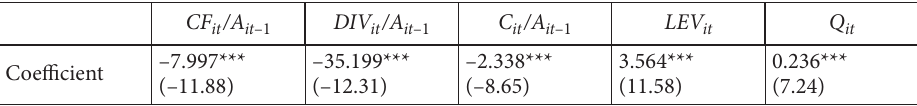
Table 7. Results of ordered logistic regression CF it /A it –1 DIV it /A it –1 C it /A it –1 LEV it Q it –7.997*** Coefficient